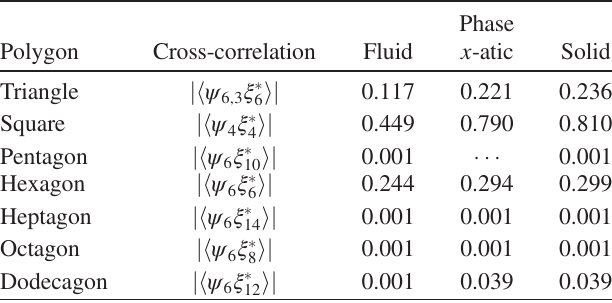
TABLE I. Cross-correlation between bond and body orienta- tion in the isotropic fluid, x -atic, and solid phases. We select the highest density pure isotropic fluid phase, the highest density pure x -atic phase, and the lowest density pure solid phase. Errors of 2 standard deviations of the mean are approximately 0.001 for all values.